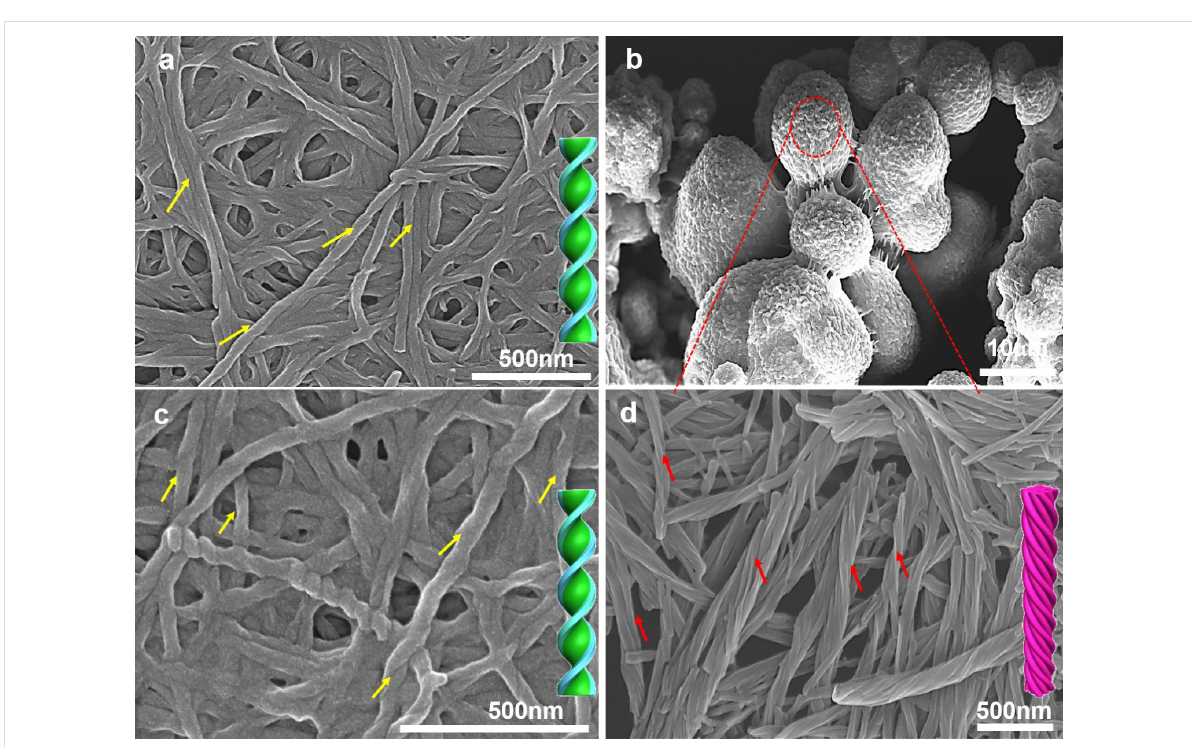
Figure 2: SEM images of NCLG assemblies in EtOH: (a) 2NCLG, (b,d) 3NCLG, and (c) 4NCLG self-assembled structures. The concentration is 12